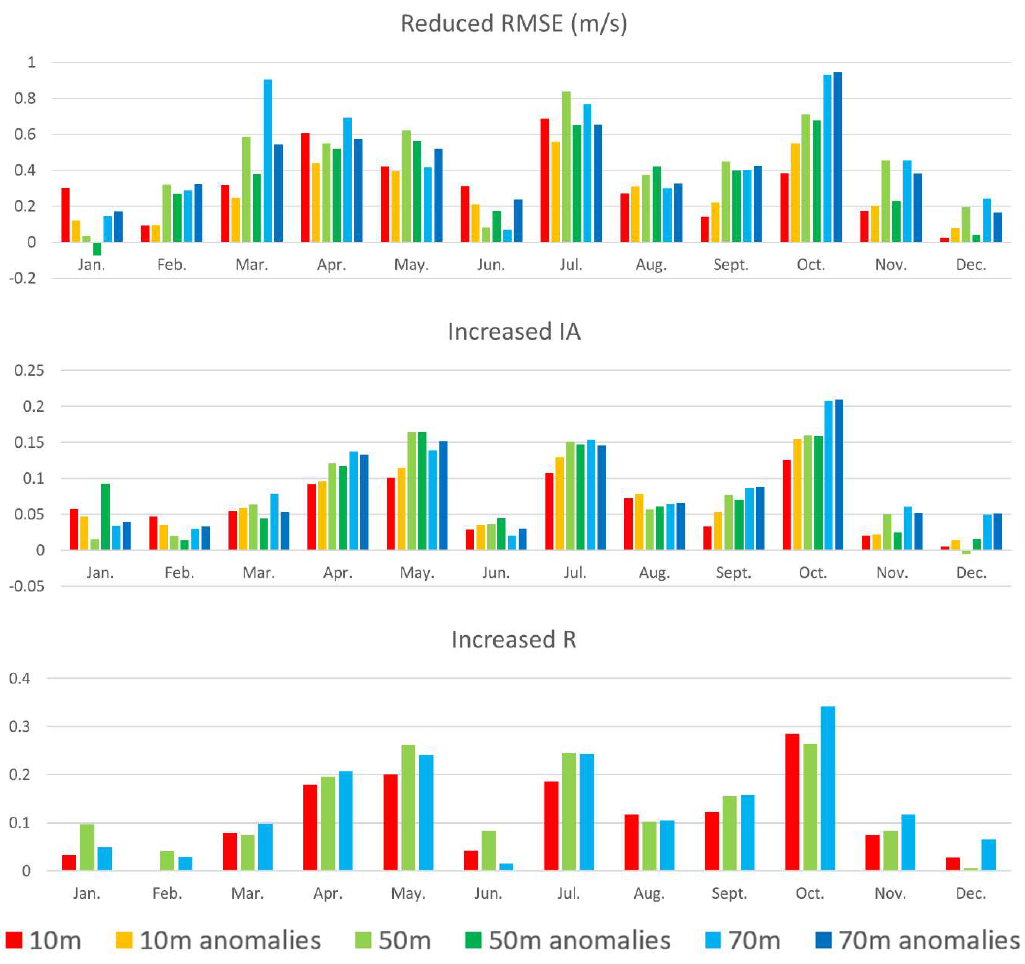
Figure 10. Difference between Test 2 and Test 1 results; “10 m”, “50 m”, and “70 m” are the reduced root-mean-square error (RMSE), increased index of agreement (IA), and increased correlation coefficient (R) results of wind speed at 10, 50, and 70 m. The “anomalies” histograms are the results of the reduced RMSE, increased IA, and increased R calculated using wind speed anomalies in Test 1 and Test 2.